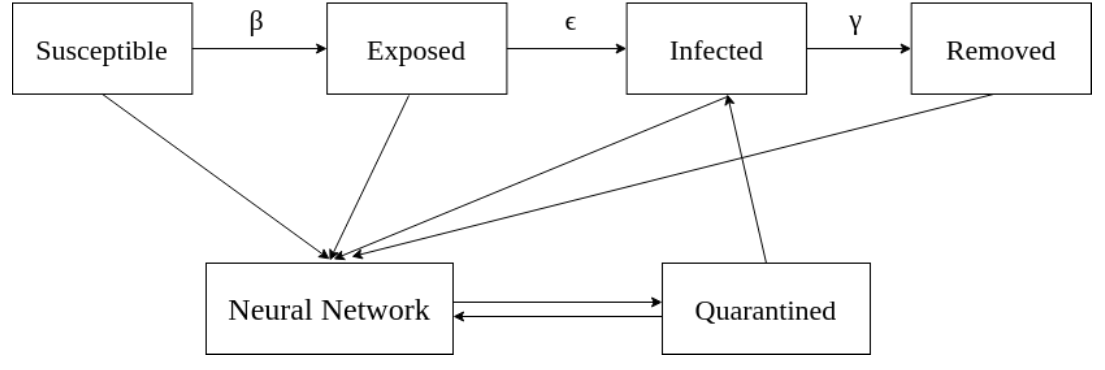
Figure 2. SEIR model with a neural